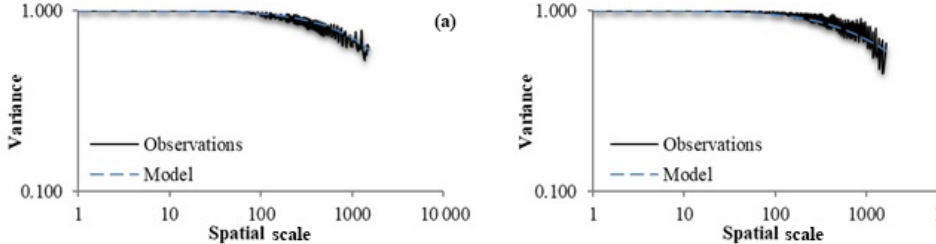
Figure 2. Climacograms for temperature borehole data at two different times.